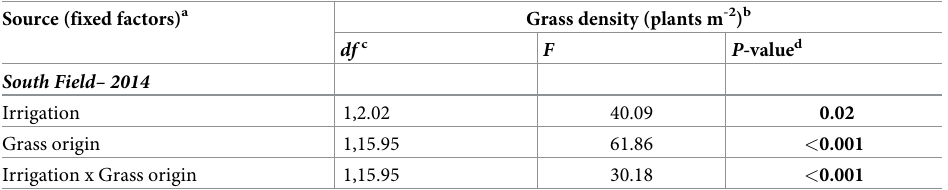
Table 5. Model results for grass density in 2014 in the South